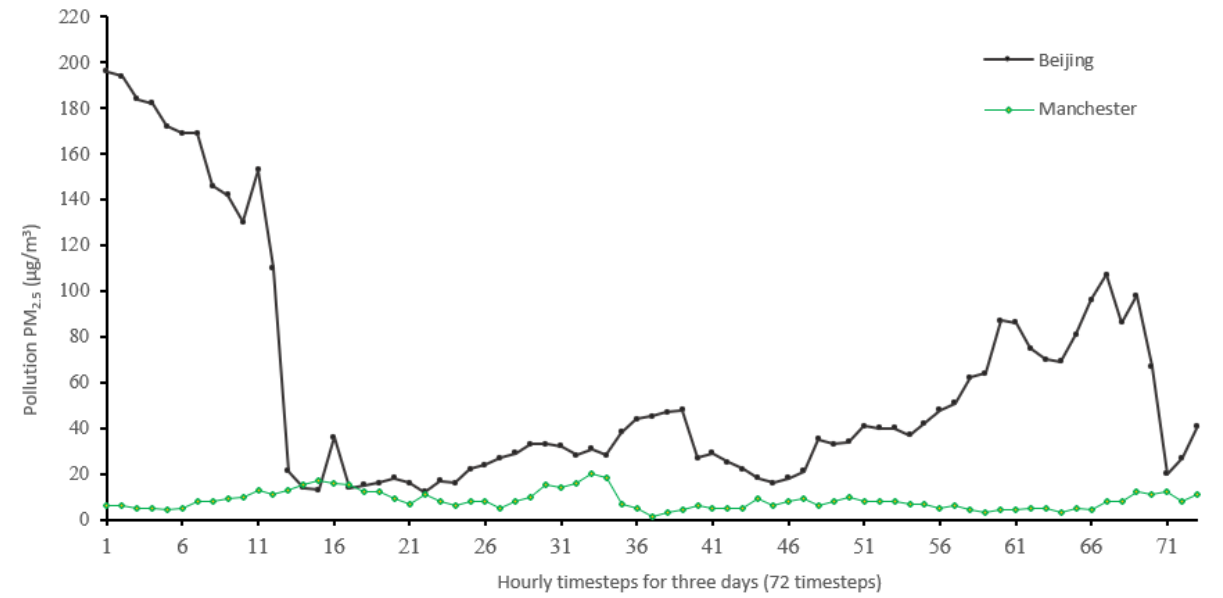
Figure 13. Real PM 2.5 data of part of the seventh iteration results comparing the Beijing vs. Manchester datasets ranges.